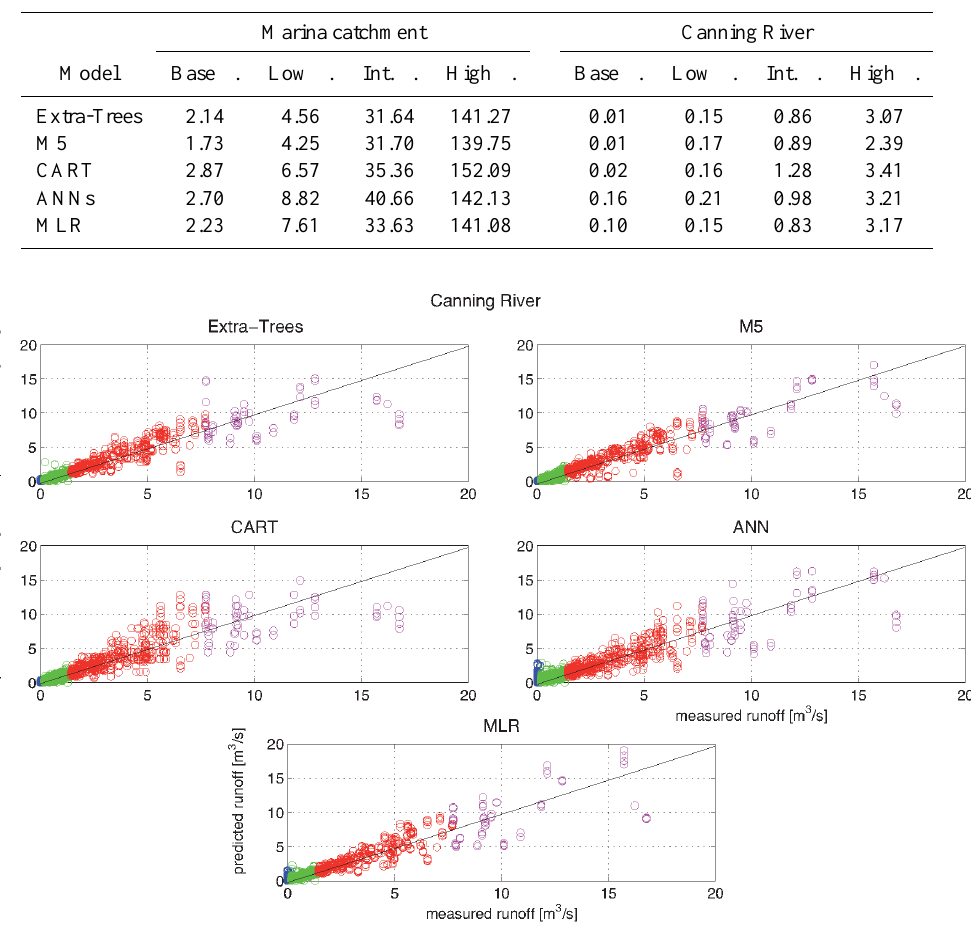
Fig. 6. Scatter plots of predicted (y-axis) and measured (x-axis) streamflow [m 3 s − 1 ] in Canning River for the different models on the testing subsets. Different colours are used to represent the flow regimes: blue, green, red and purple correspond to base, low, intermediate and high flow,